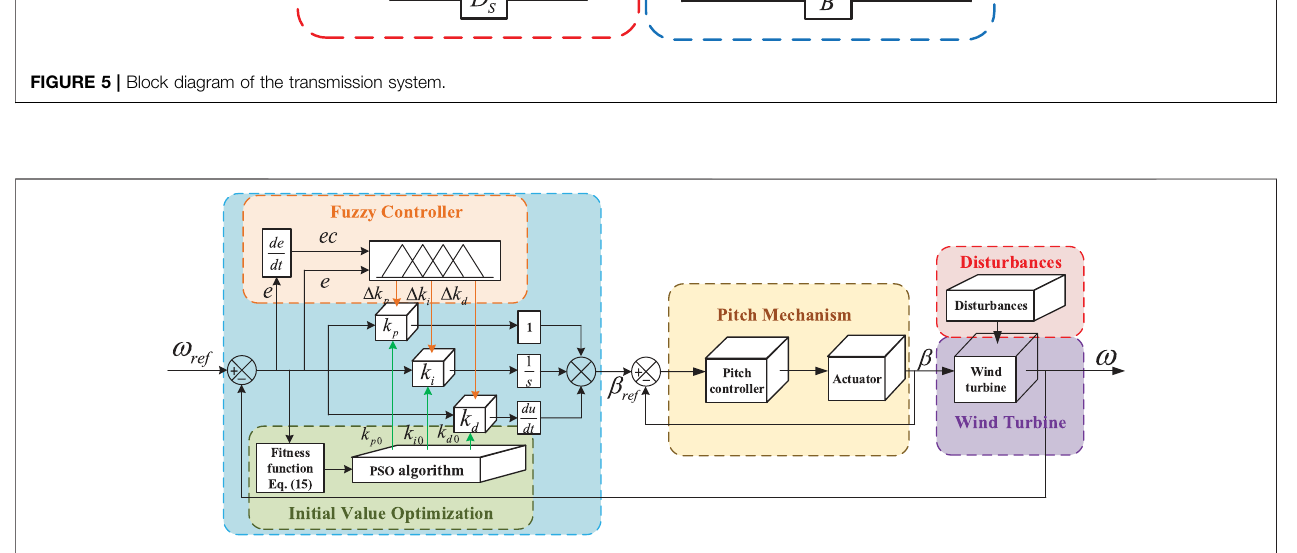
FIGURE 6 | Block diagram of pitch control based on fuzzy PSO-PID